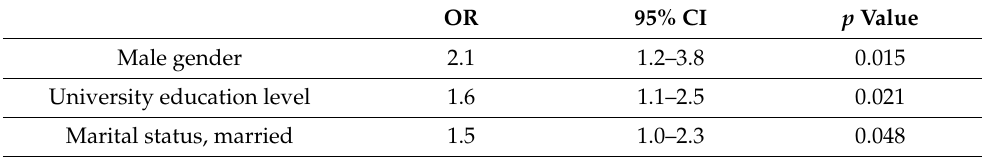
Table 2. Logistic regression model for variables predicting vaccine willingness. OR 95% CI p Value Male gender 2.1 1.2–3.8 0.015 University education level 1.6 1.1–2.5 0.021 Marital status, married 1.5 1.0–2.3